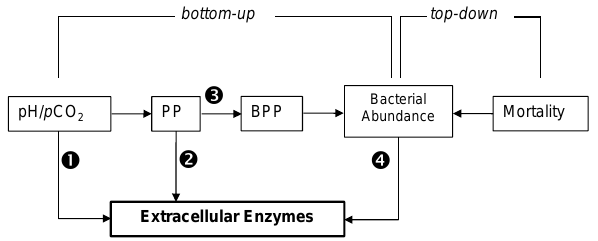
Fig. 13. Pathways of direct pH effects and indirect p CO 2 effects on extracellular enzyme activity in the mesocosm plankton commu- nity. (1) Biochemical pH effect on enzymatic reaction velocity, (2) effect of primary production (PP) on bacterial enzyme production, (3) effect of PP on bacterial protein production (BPP), (4) effect of bacterial abundance on bulk enzymatic activity. See text for further